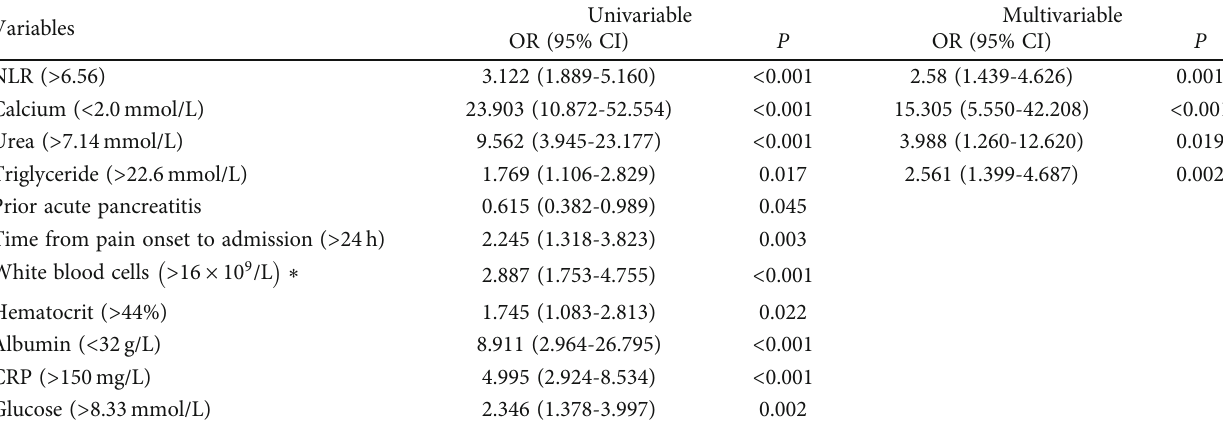
Table 2: Univariate and multivariate logistic regression analyses for persistent organ failure.